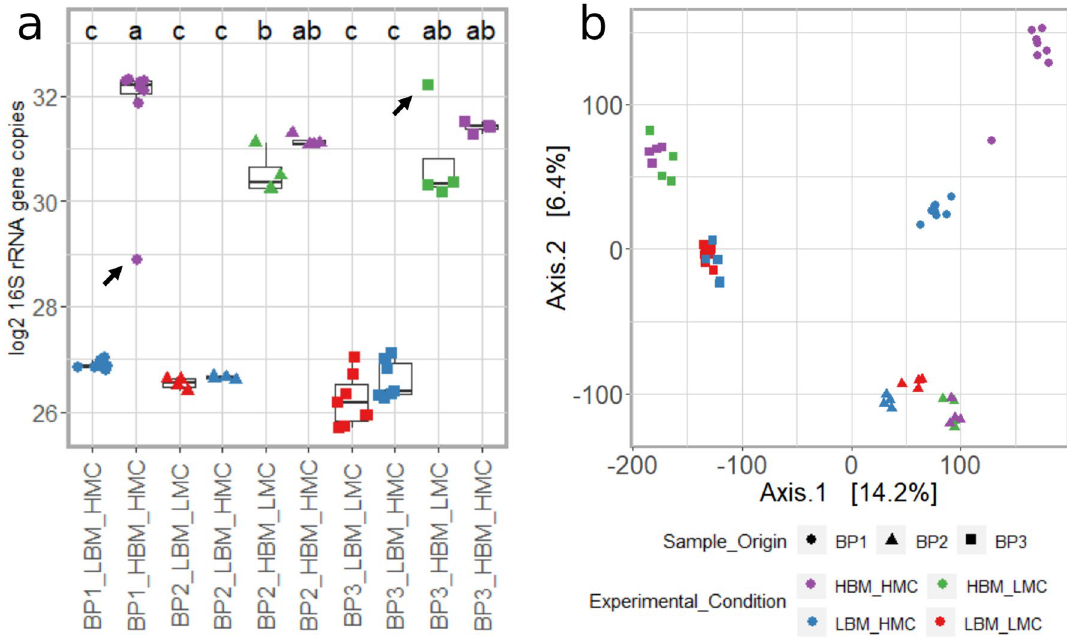
Figure 4. 16S rRNA gene copy number and beta diversity estimates for bovine fecal microbiota with high and low biomass and mock community. ( a ) Log 2 16S rRNA gene copies estimated from the abundance of I. halotolerans —SVs in each library. the MC of the same library. Results from Tukey HSD test on the ANOVA results are indicated by ( a – c ). The black arrows indicate two potential outliers, characterized by an unexpected number of 16S rRNA gene copies: orange circle: 9.84 time fewer copies; purple square: 3.78 times more copies. ( b ) PCAs were generated by using Euclidean distance. SV counts were transformed according to the abundance of